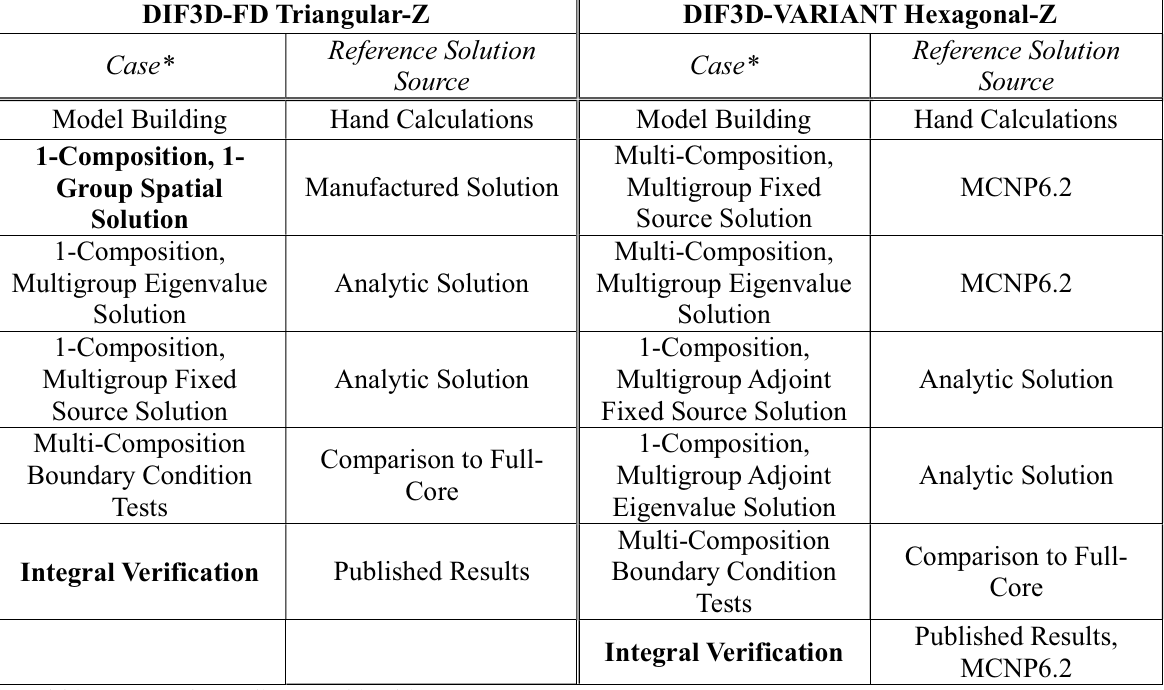
Table I. Overall DIF3D Verification